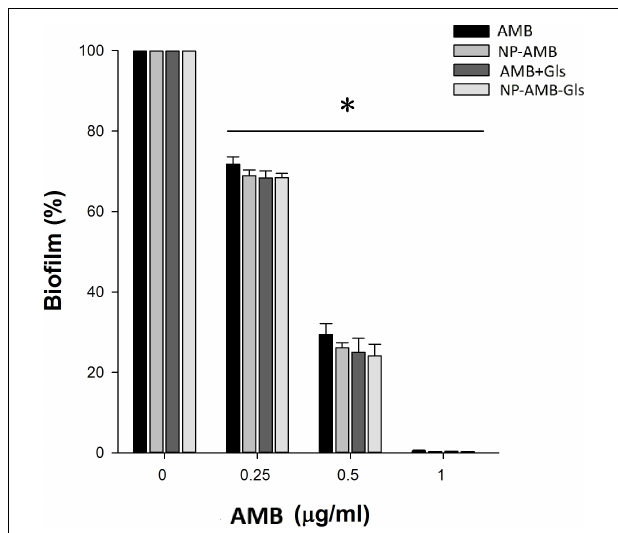
FIGURE 5 | Eradication efficacy of NPs on the mature biofilm by C. albicans DAY 185 in a 96-well microplate. Mature biofilms were treated with different concentrations (0, 1, 2, and 4 µ g/ml) of free AMB, AMB+Gls, CSNPs-AMB, and CSNPs-AMB-Gls for 24 h. The results represent the means and SDs (error bars), n = 3. Statistical significance was determined by the t -test analysis. ∗ p < 0.05 for a comparison between the untreated and treated groups. # p < 0.05 for a comparison between CSNPs-AMB-Gls and other treated